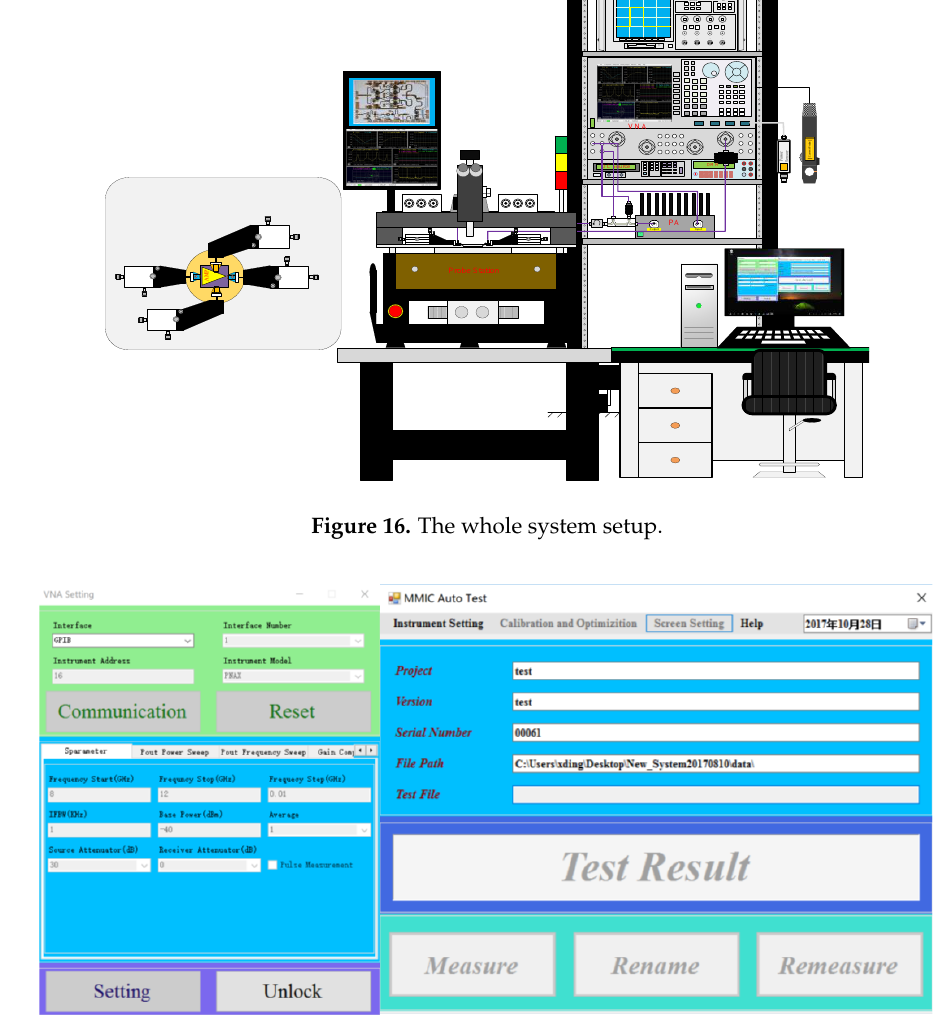
Figure 17. Automatic test control software HMI.